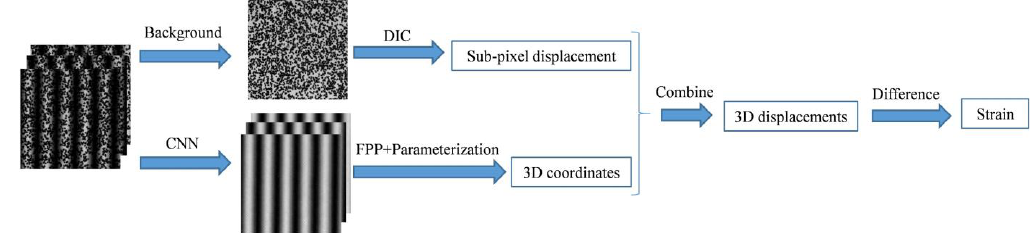
Figure 1. Flow chart of the proposed measurement method.